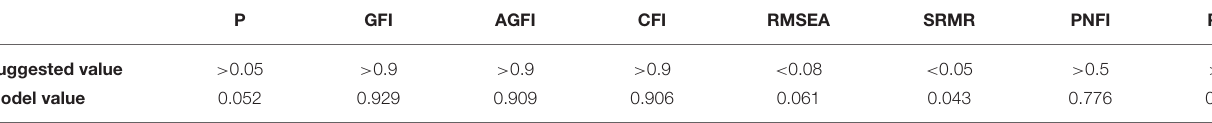
TABLE 3 | Model fit of the default SEM model.